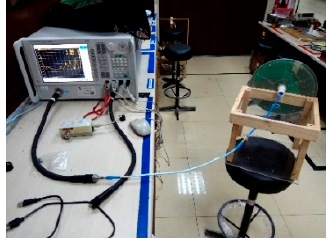
Figure 23. Photo of the VSWR measurement setup using the N5227A PNA Microwave Network Analyzer.